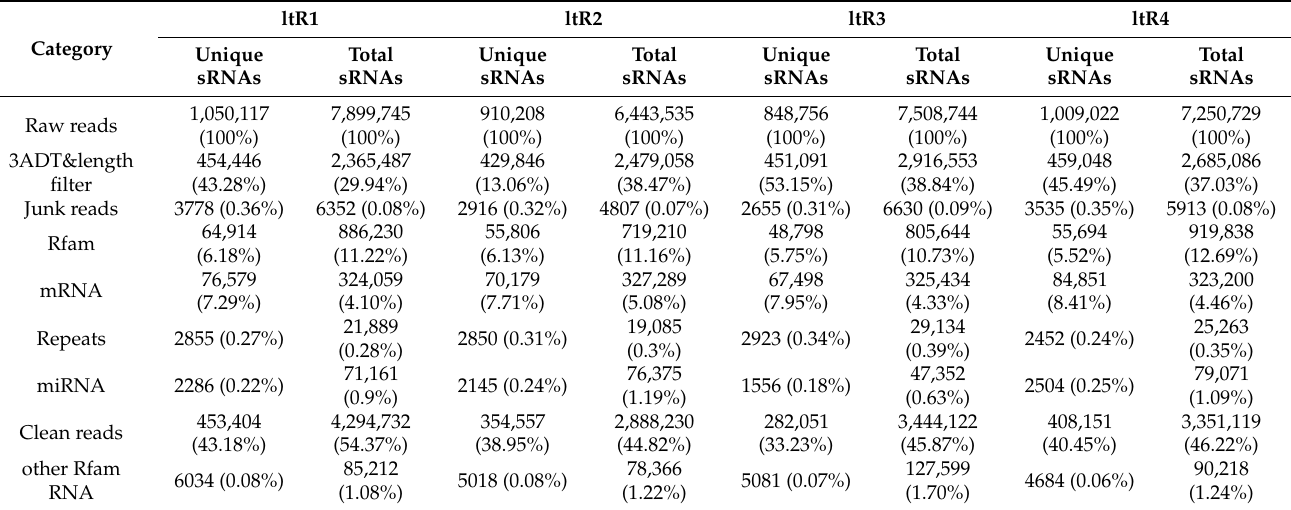
Table 1. Statistical data of sRNAs sequences in resistant, susceptible and control